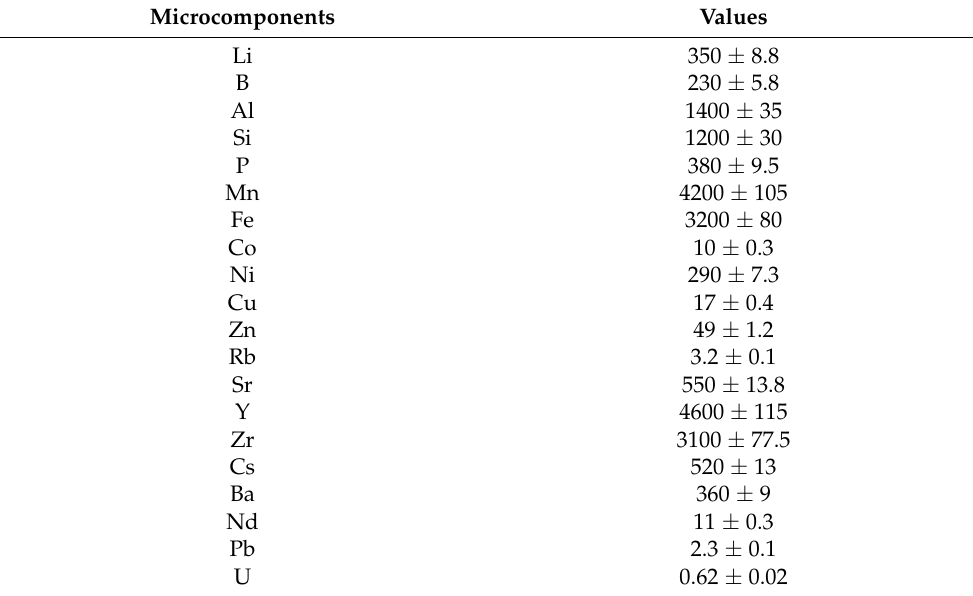
Table 2. Trace element concentrations in the water sample, µ